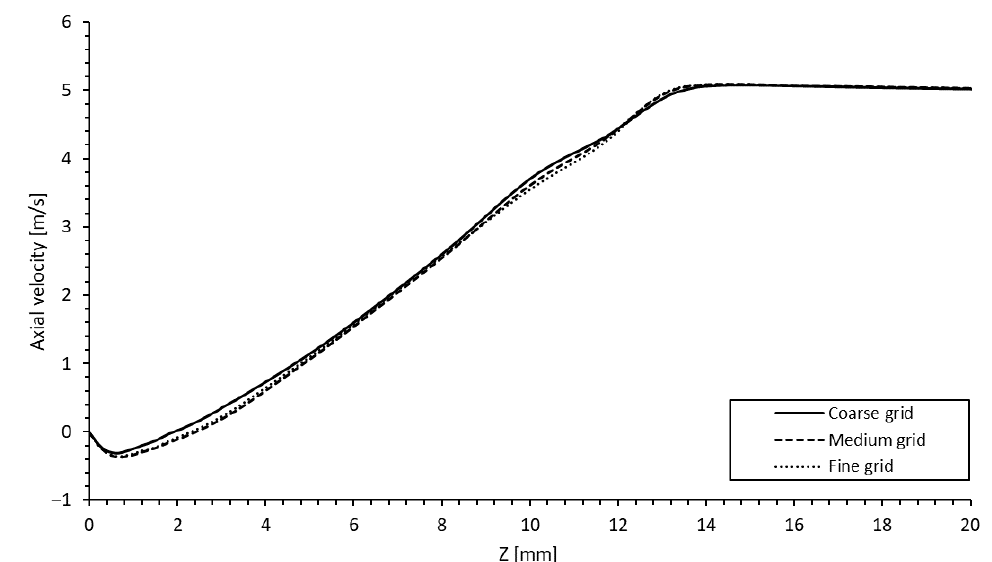
Figure 7. Simulated axial velocity for the three grids at R4. The ordinate is clipped at Z = 20.